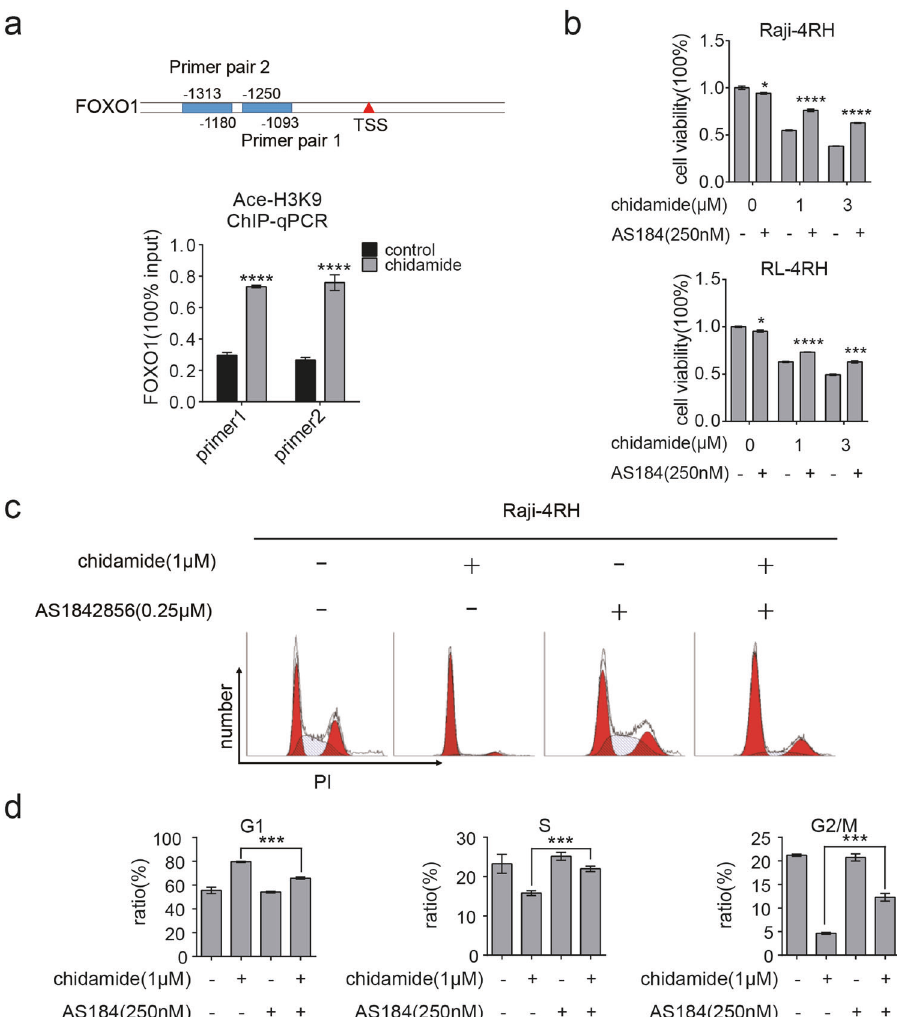
Fig. 5 FOXO1 was a target gene of chidamide to mediate cell cycle arrest. a Raji-4RH was treated with chidamide (3 μ M) or DMSO for 24 h and then cells were collected for ChIP assay. DNA fragments were pulled down with Ace-H3K9 antibody or negative IgG antibody. Enrichment of FOXO1 promoter sequences were examined by Q-PCR analysis and normalized to input chromatin DNA, and primers were designed as the sketch indicated ( N = 3). b Raji-4RH and RL-4RH cells were treated with AS184 (250 nM) and chidamide (1 or 3 μ M) alone or in combinations for 48 h, and cell viability were examined by MTT assay ( N = 3). c , d Raji-4RH and RL-4RH cells were treated with AS184 (250 nM) and chidamide (1 μ M) alone or in combinations for 48 h, and cell cycle were examined by fl ow cytometry ( c ) and shown in histograph ( N = 3) ( d ). For all graphs, data are presented as mean ± SD, * p < 0.05, ** p < 0.01, p < 0.005***, p < 0.001****. Statistical analysis was performed with a paired t